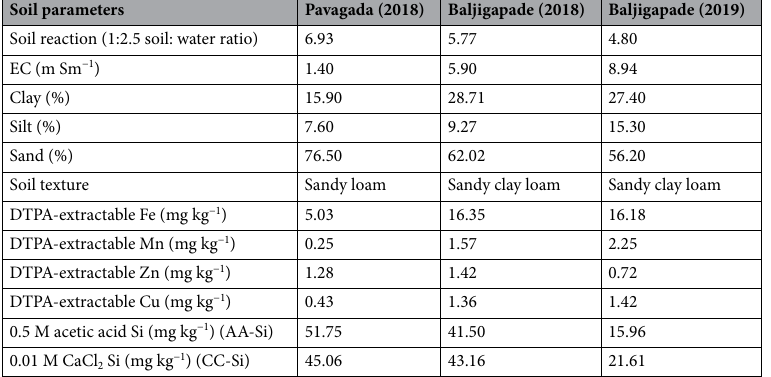
Table 1. Initial soil characteristics of experimental sites. Each value represents the mean value of three replications.